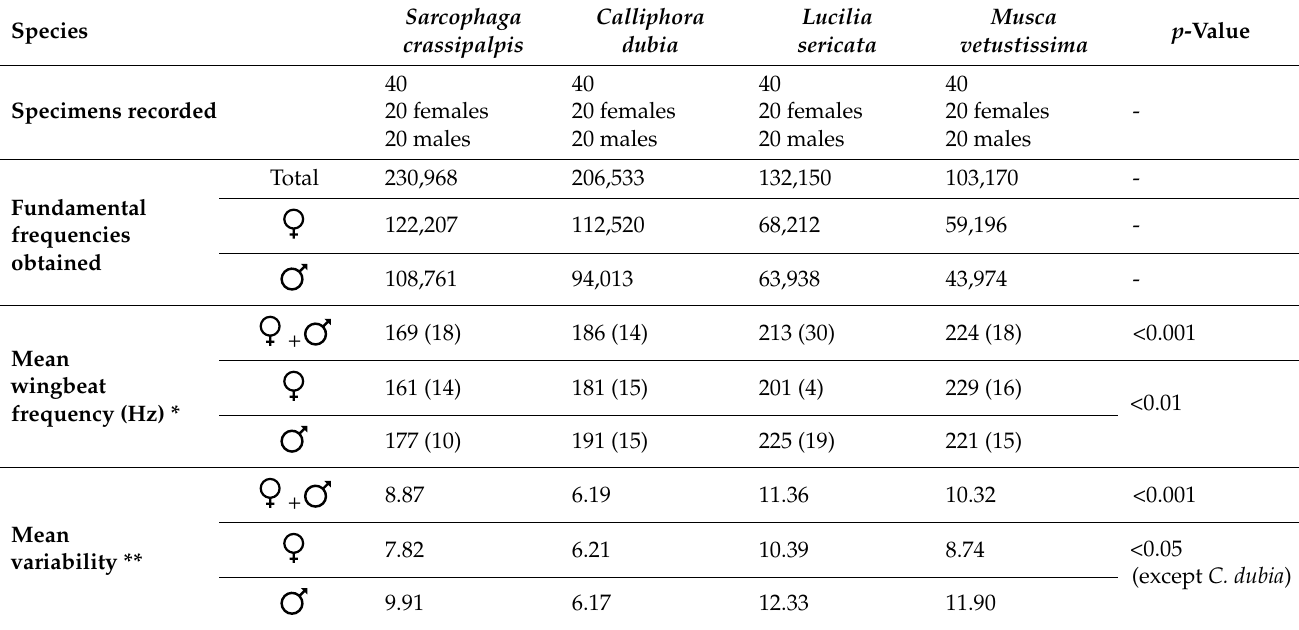
Table 2. Mean wingbeat fundamental frequencies and variability.